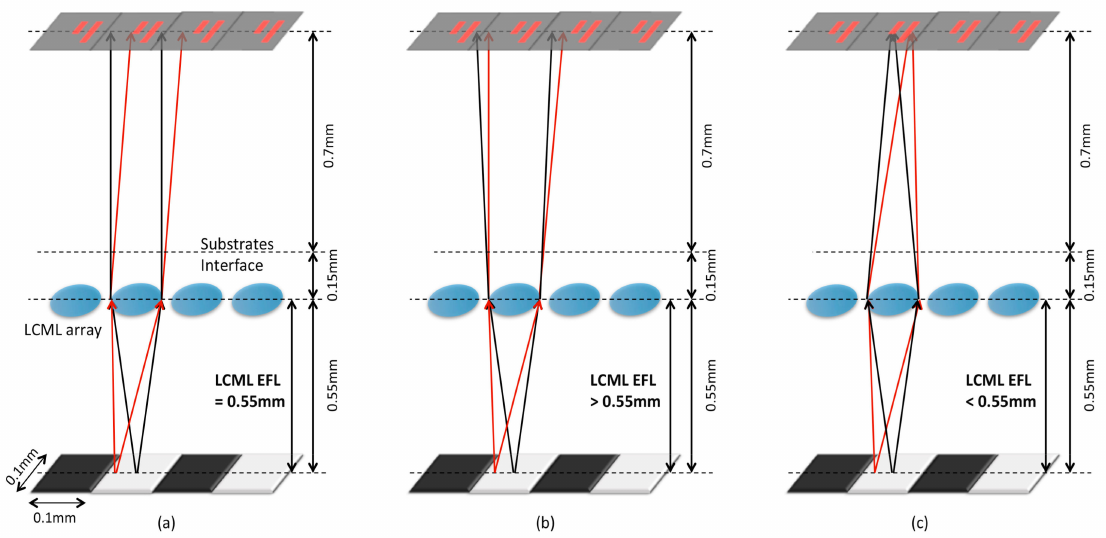
Figure 2. A sketch of a liquid crystal micro-lens (LCML) on the TFPT imager as the LCML effective focal lengths (EFL) is ( a ) equal to, ( b ) greater than, or ( c ) less than 0.55